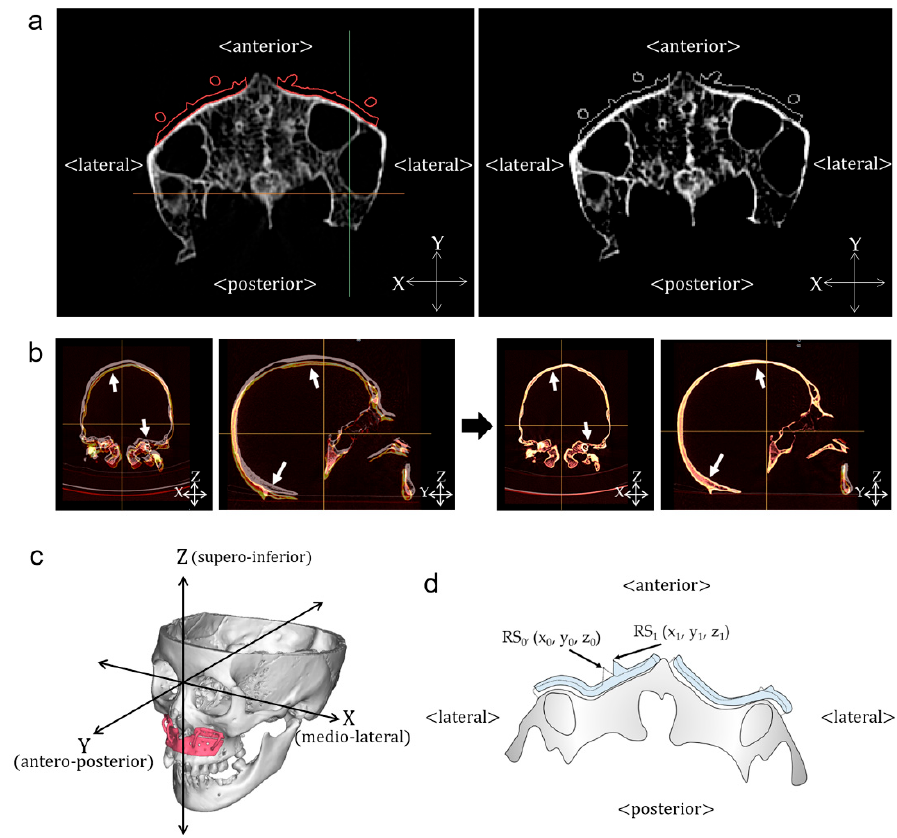
Figure 2. Deviation of the CAD/CAM-based surgical templates. ( a ) Surgical template combined with the computed tomography (CT) data at T0; the left image was obtained prior to the surgical template being combined with the CT data (T0). Surgical template (red) was separated from the CT data (T0); the right image was obtained after the combination of the surgical template with the CT data (T0). CT data (T0) combined with the surgical template were exported to a Digital Imaging and Communications in Medicine (DICOM) format (T0 ′ ). ( b ) Superimposition of the CT data at T0 ′ and T1 on the basis of the best fit of the cranial base structures. ( c ) A three-dimensional (3D) coordinate system used in this study. ( d ) Assessment of the 3D coordinates for each cone-shaped reference structure (RS) in T0 ′ (dotted line) and T1 (solid line).